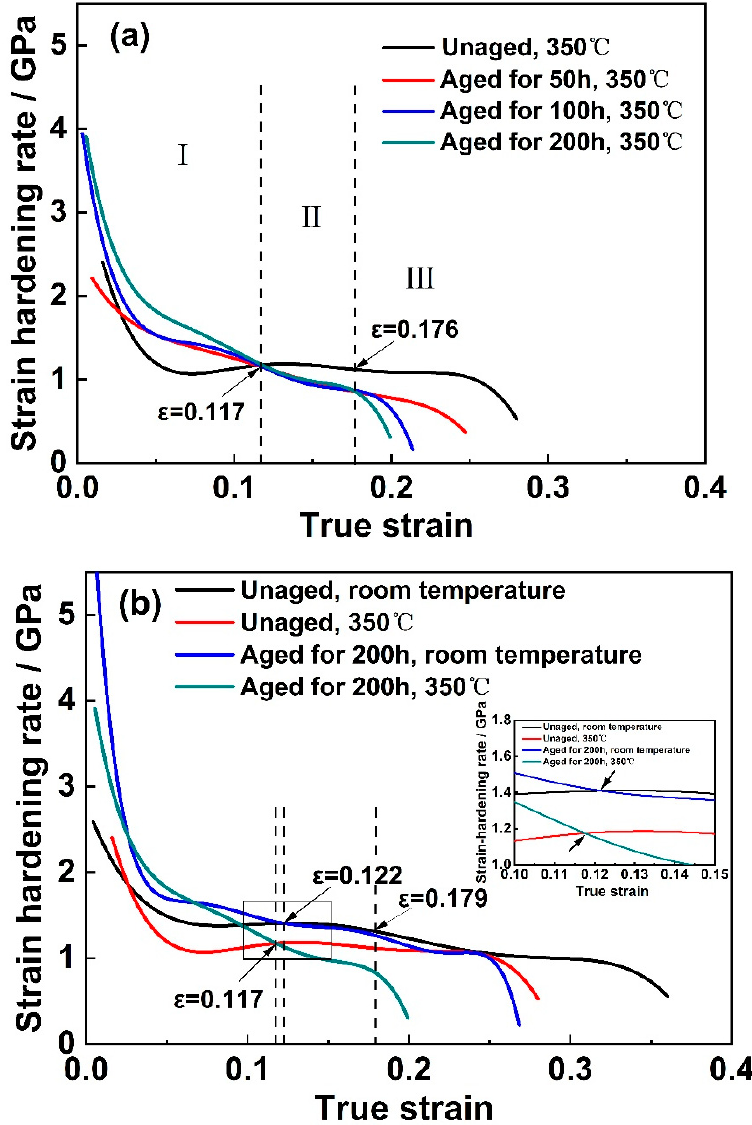
Figure 14. Strain-hardening rate of aged and unaged Z3CN20.09M specimens at different tempera- tures: ( a ) 350 °C, ( b ) 350 °C and room temperature.